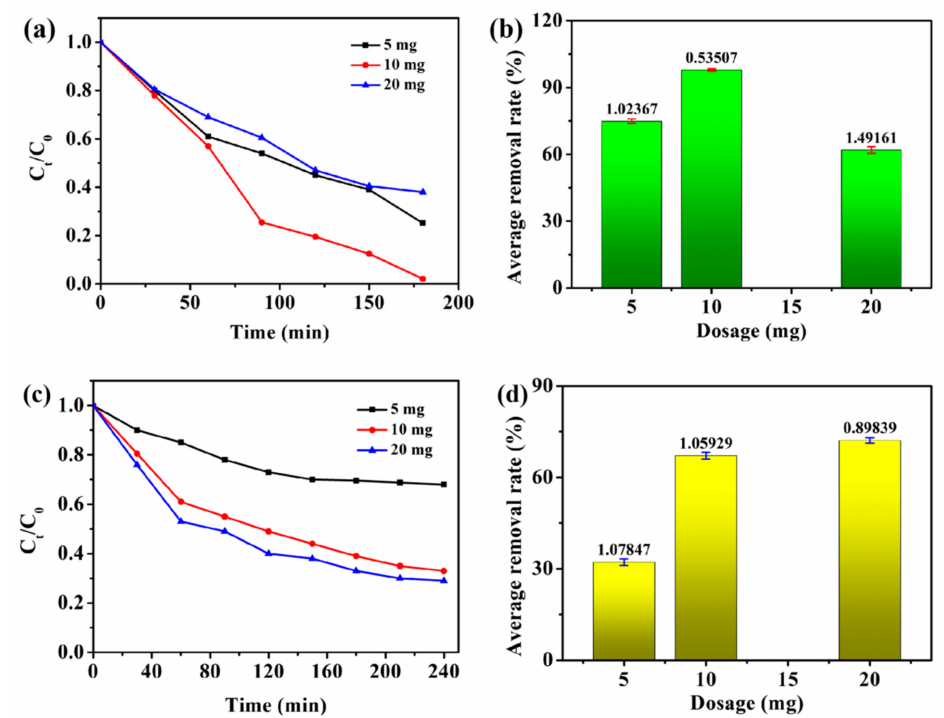
Figure 7. ( a ) Effect of different catalyst 1 dosages on TC degradation. ( b ) Average removal rate of TC degraded by catalyst 1 . ( c ) Effect of different catalyst 2 dosages on TC degradation. ( d ) Average removal rate of TC degraded by catalyst 2